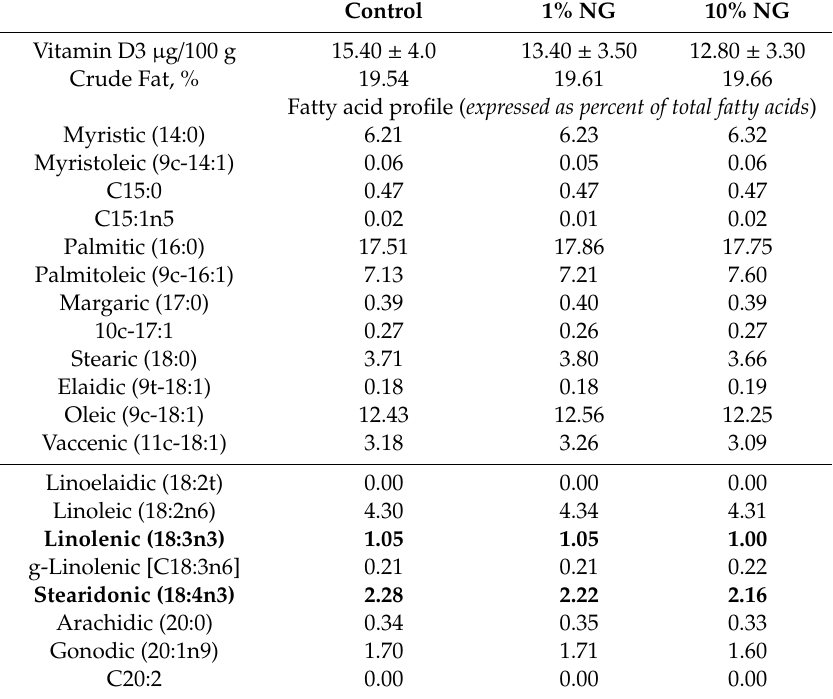
Table 4. Fatty acid and vitamin D 3 composition of experimental